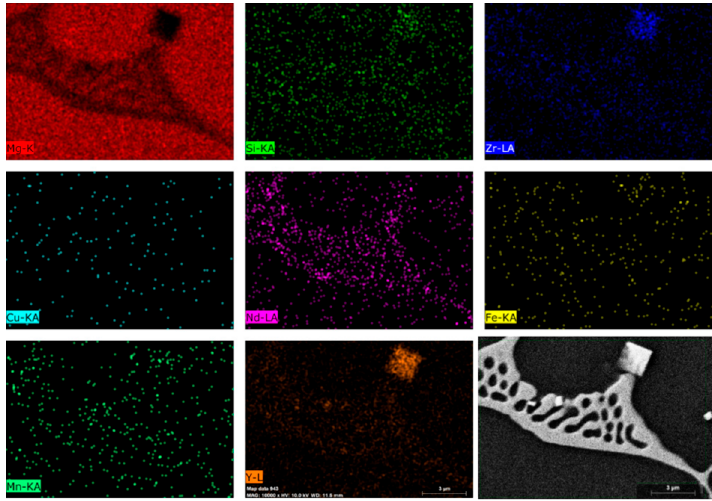
Figure 3. Energy dispersive spectrometry (EDS) map scan of WE43 base material image showing the distribution of elements in alloy.